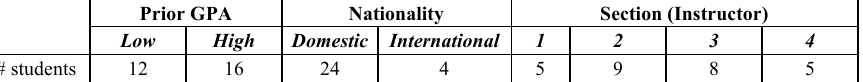
Table 1. Distribution of the interview participants across the stratification